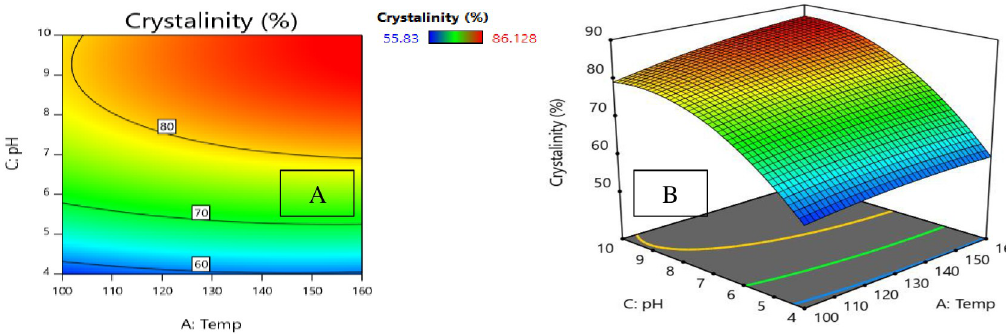
Fig 9. A: 2D contour plots and B: 3D surface plots for the effects of pH and temperature on the degree of crystallinity at time 10 h.